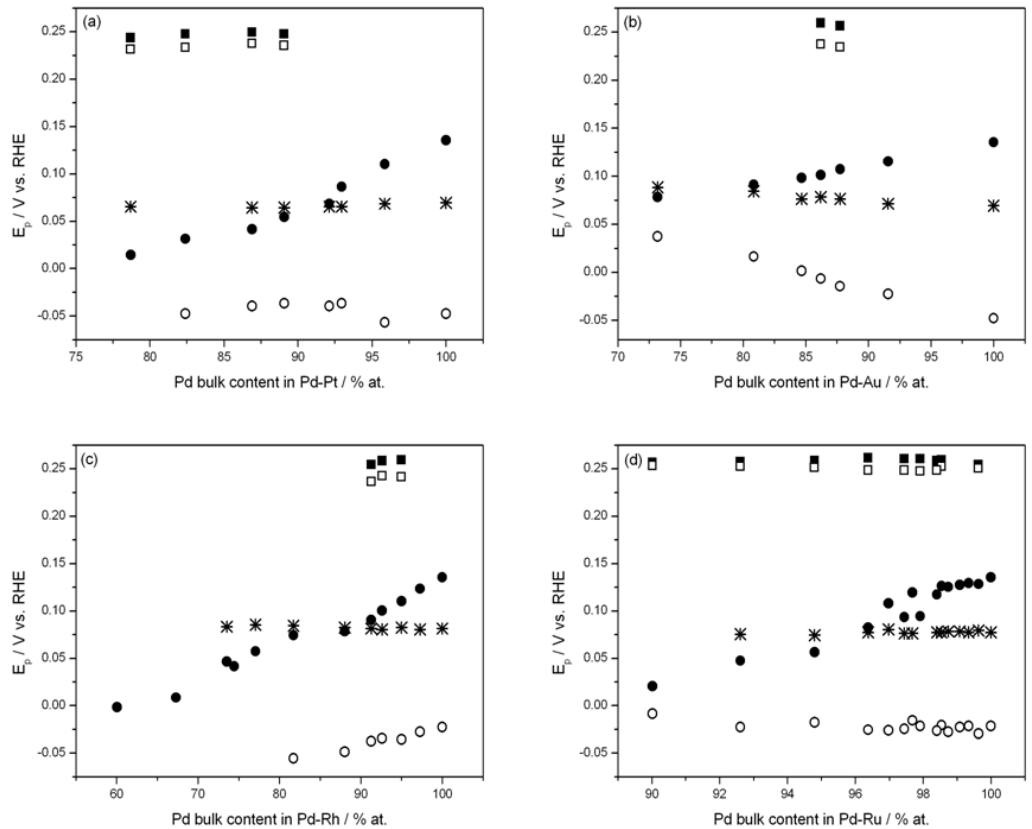
Figure 4. Influence of alloy bulk composition on potentials of voltammetric peaks due to hydrogen sorption and desorption. Temperature 298 K. ( a ) Pd-Pt alloys; ( b ) Pd-Au alloys; ( c ) Pd-Rh alloys; ( d ) Pd-Ru alloys; (■) anodic signal 1, sorption at −0.11 V; (□) cathodic signal 1; (●) anodic signal 2, sorption at −0.11 V; (○) cathodic signal 2; (*) anodic signal 2, sorption at 0.07